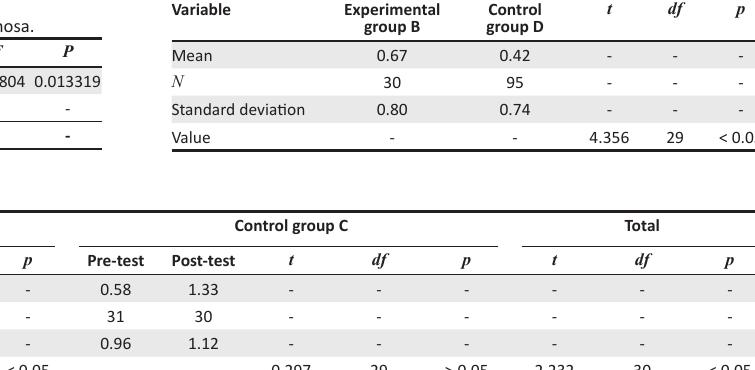
Standard deviation